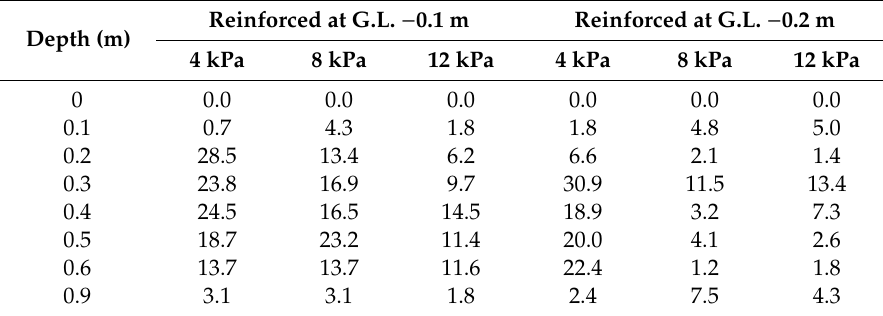
Table 2. Comparison of the reinforced ground and non-reinforced ground in terms of the stress reduction ratio. Depth